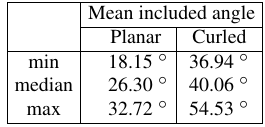
Table 2. Mean included angle statistics for planar and curled